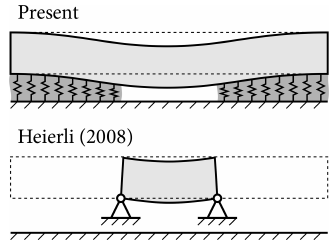
Figure 12. Impact of model assumptions on slab deformations. Heierli (2008) considers only the unsupported section of the slab and, hence, does not account for deformations of the beam segment resting on the intact weak layer, which contributes to the total stored energy.